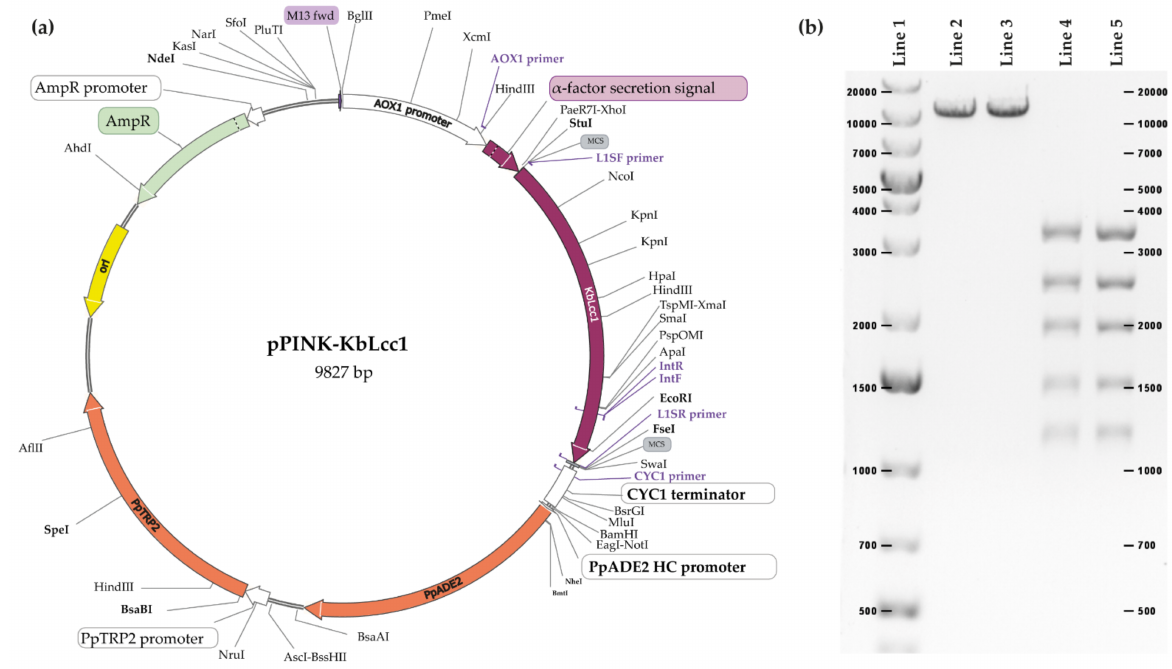
Figure 3. Construct of pPink α -HF vector with the insert of laccase KbLcc1 coding sequence ( a ) and its restriction analysis ( b ); DNA fragments length marker (line 1), product after SpeI enzyme treatment (lines 2 and 3), products after multi-enzymes digestion with SpeI, AscI, NdeI and EcoRI (lines 4 and